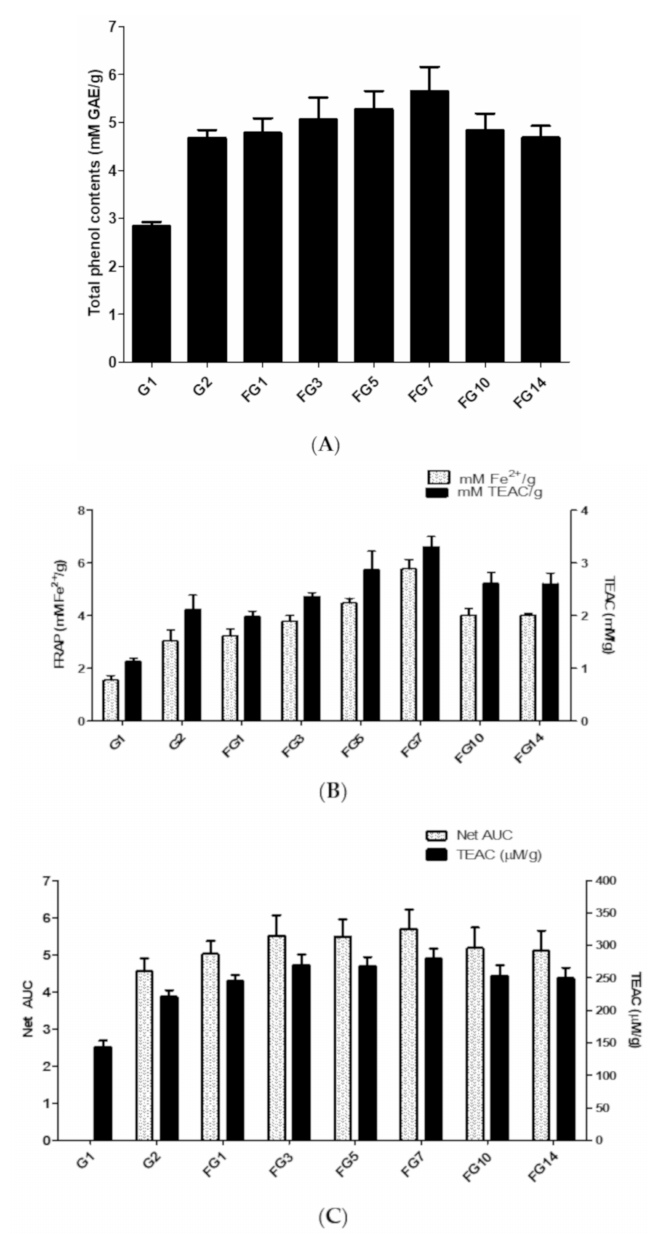
Figure 3. Total phenol content ( A ), ferric reducing antioxidant power (FRAP, B ) and oxygen radical absorbance capacity (ORAC, C ) of fermented wild ginseng by R. oligosporus . G1: wild ginseng extract; G2: autoclaved wild ginseng extract; FG1: 1-day fermented wild ginseng extract; FG3: 3-day fermented wild ginseng extract; FG5: 5-day fermented wild ginseng extract; FG7: 7-day fermented wild ginseng extract; FG10: 10-day fermented wild ginseng extract and FG14: 14-day fermented wild ginseng extract. All experiments were performed in triplicate and all data were expressed as the mean ± standard deviation. TEAC: Trolox equivalent antioxidant